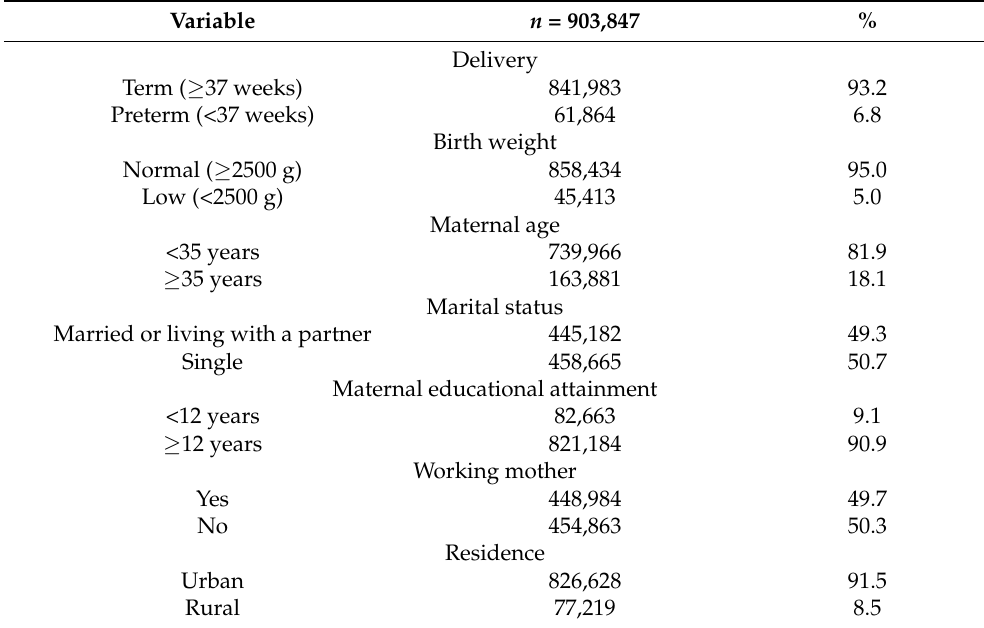
Table 1. Studied maternal factors of Chilean newborns.